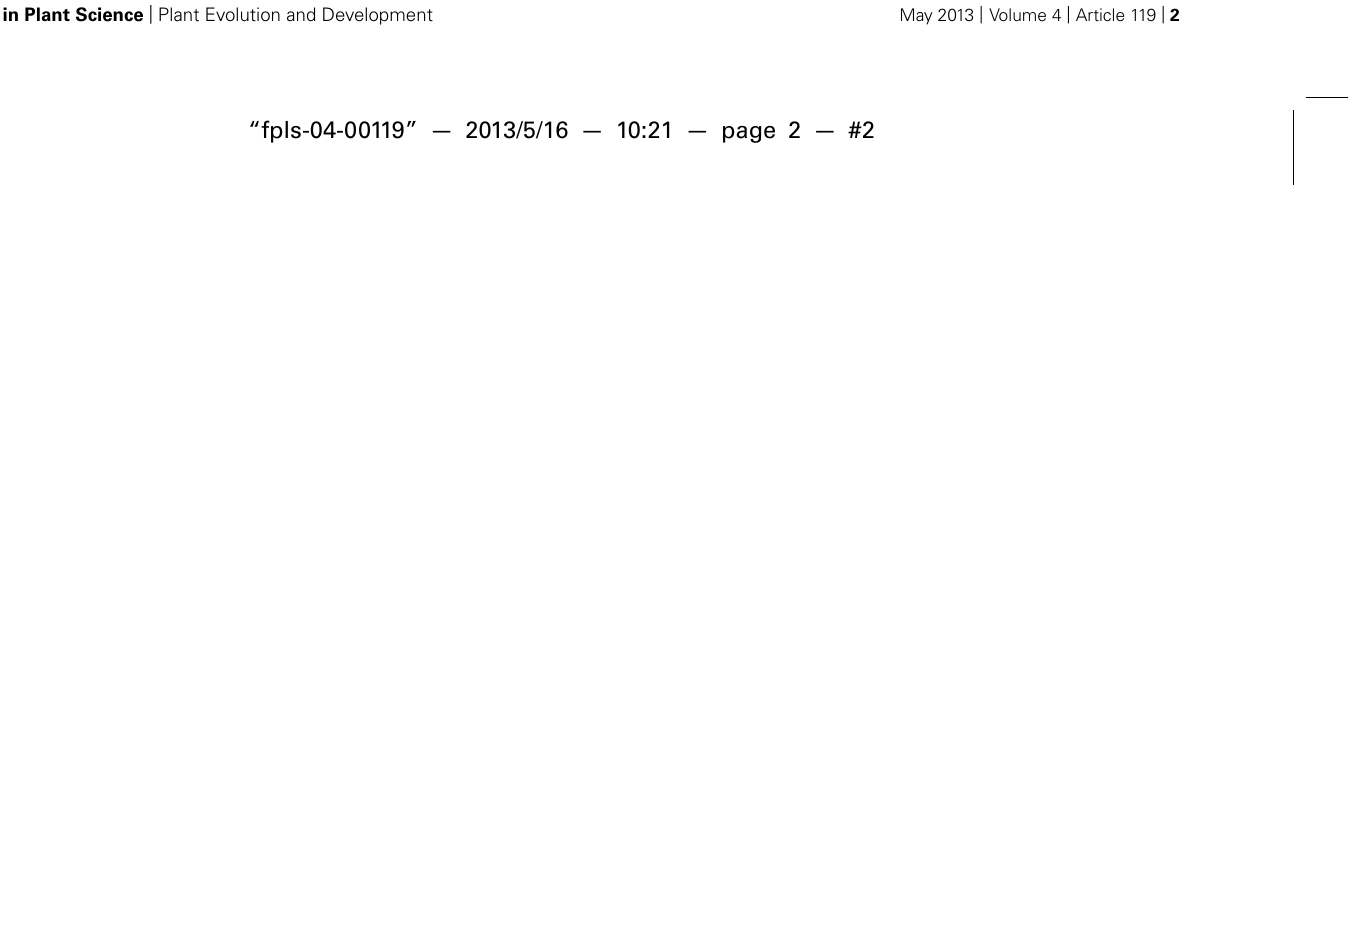
representative of the green plant lineage is shown.The proportion of the sum of these genes in relation to the haploid gene complement is denoted on top of each bar. Due to our currently limited knowledge of the temporal expression and biochemical function of specialized metabolic enzymes, the enzyme families and numbers of members listed likely underestimate the true biosynthetic potential of any green